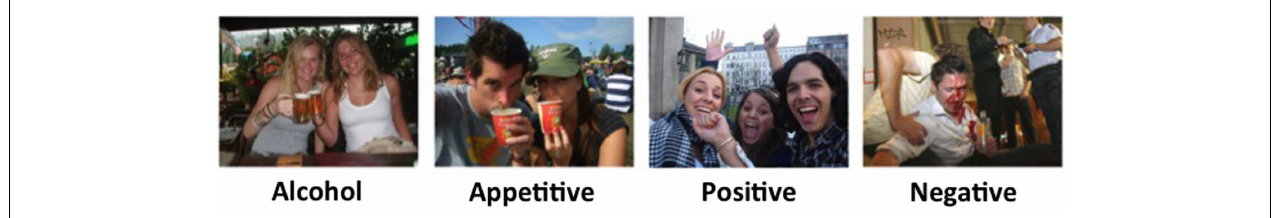
FIGURE 1 | Examples of pictures in the alcohol, appetitive, positive, and negative category